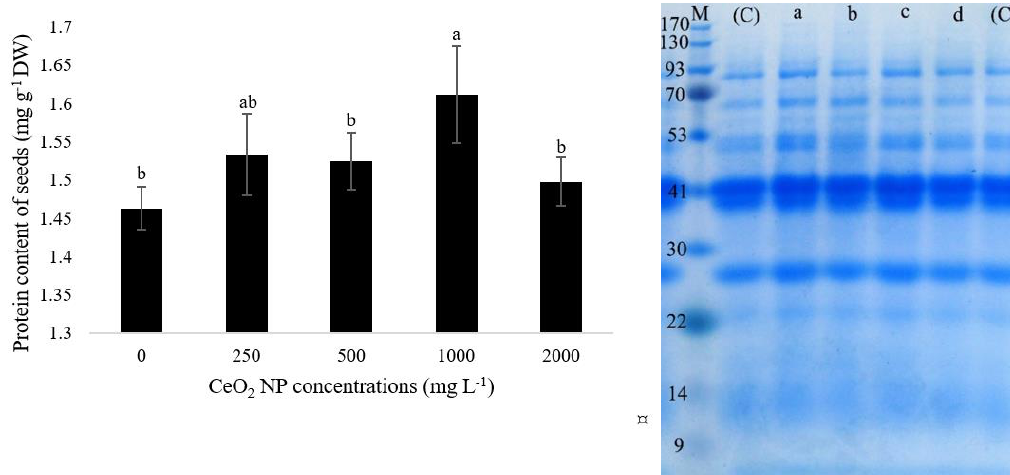
Figure 6. Total soluble protein content in bean seeds of plants exposed to different concentrations of nCeO 2 compared to control ( left ). SDS-PAGE profile of protein extracted from bean seeds in control and treated plants ( right ). (C, a, b, c, and d are related to control, 250, 500, 1000, and 2000 mg L − 1 concentrations, respectively). M: molecular mass marker (CinnaGen Company). Data are means ± SE. Means followed by the same letter are not significantly different (Duncan’s test p ≤